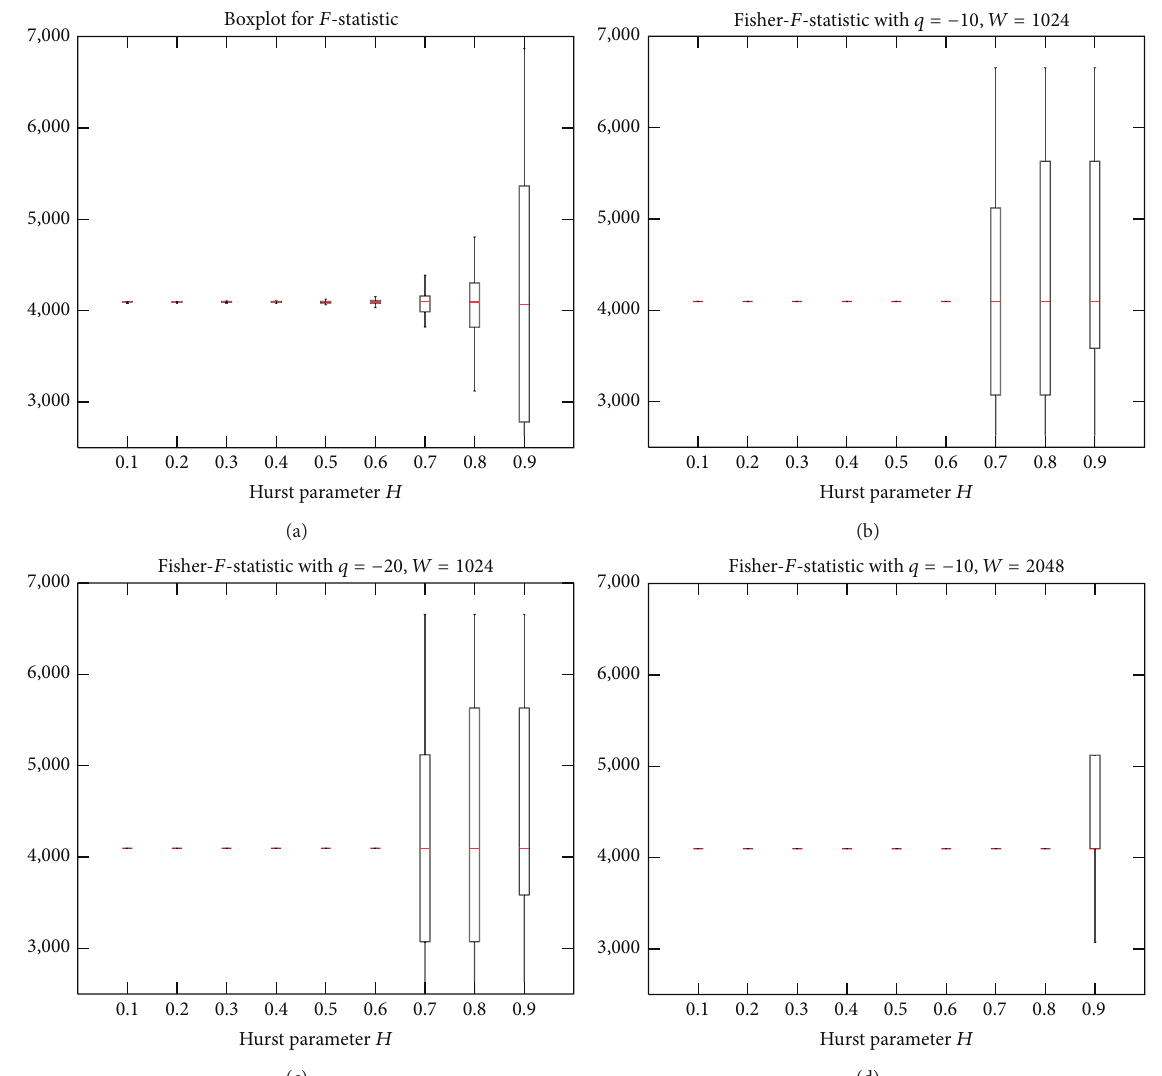
Figure 6: Boxplots that represent the detection capabilities of the 𝐹 -statistic (top left plot) and several version of the joint Fisher/ 𝐹 -statistic procedure for fractional Gaussian noise signals. Top right plot displays the results for the joint technique using 𝑊 = 1024 and 𝑞 = −10 , bottom left plot shows the results for the joint technique with 𝑊 = 1024 and 𝑞 = −20 and finally bottom right plot presents the results for the joint technique with 𝑊 = 2048 and 𝑞 = −10 . The level shift was located at 𝑡 = 4096